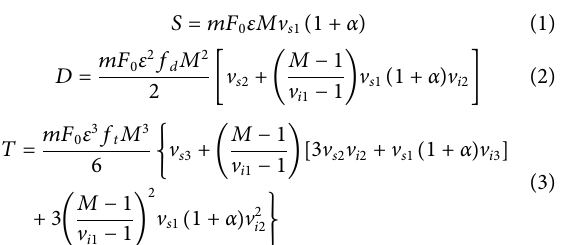
FIGURE 4 Simulated mass of different shaped samples.